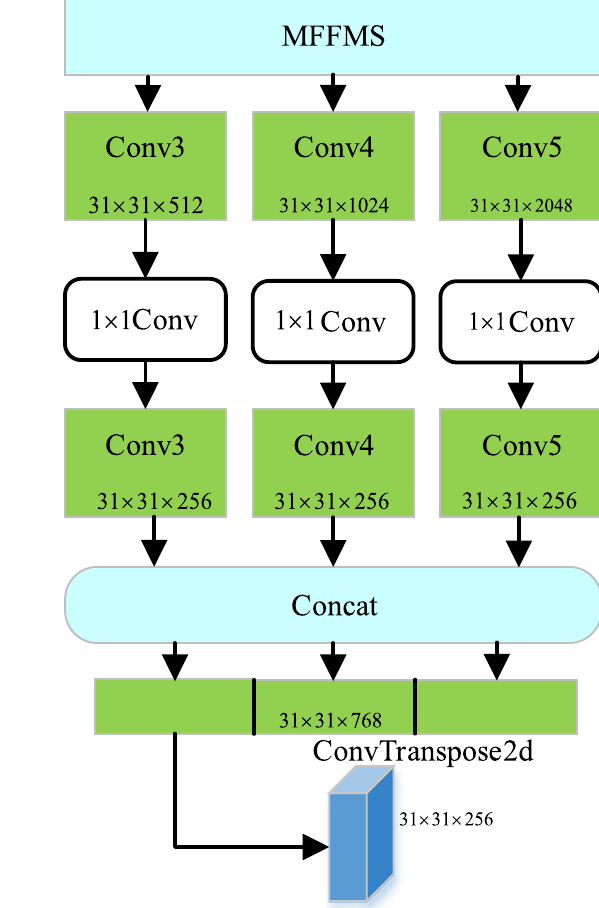
Fig. 3 Feature extraction of MFFMS